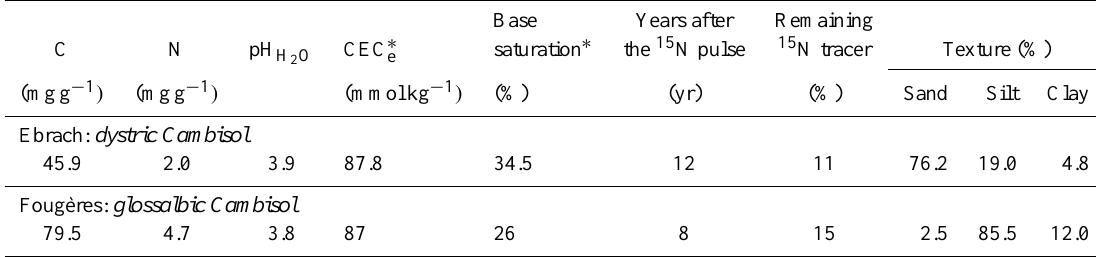
Table 2. Basic properties of the first 2.5cm of the mineral soil.